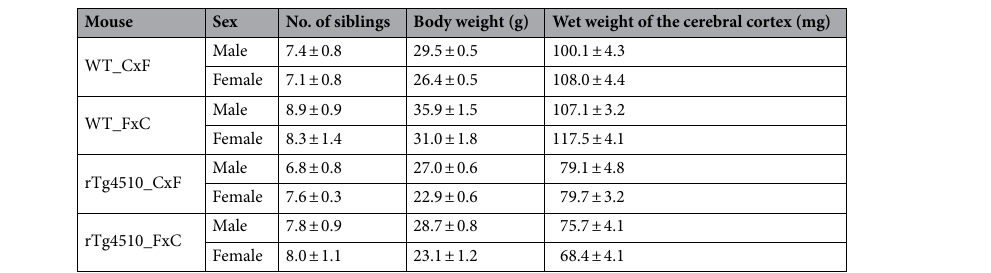
Table 2. Summary of the number of siblings, body weights, and brain